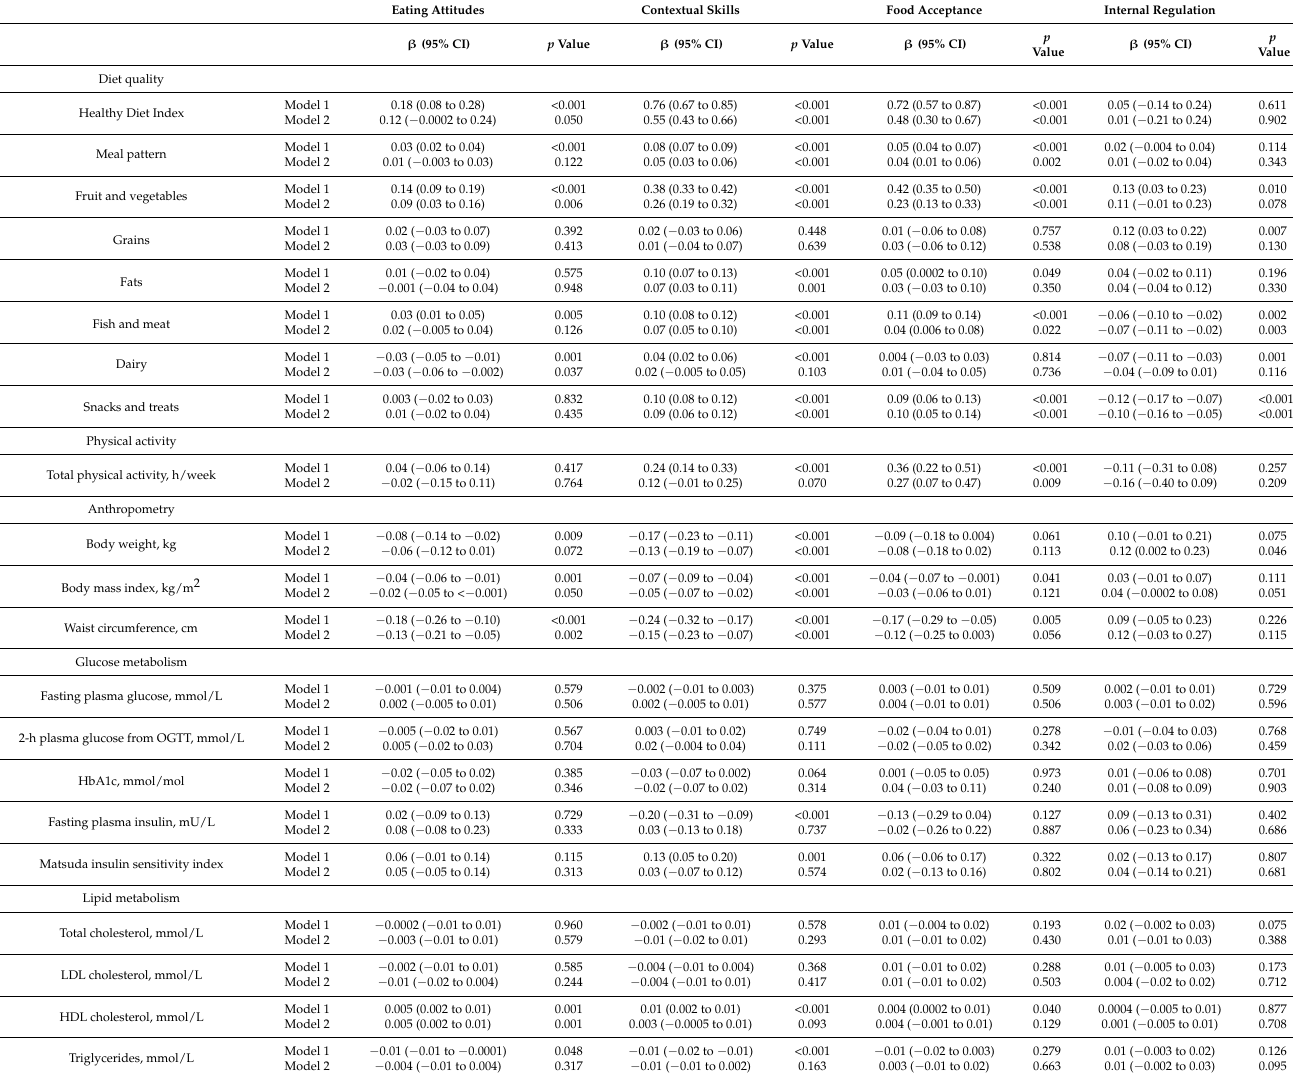
Table A1. Associations of changes in eating competence (EC) sub-scores with changes in lifestyle and metabolic factors over one